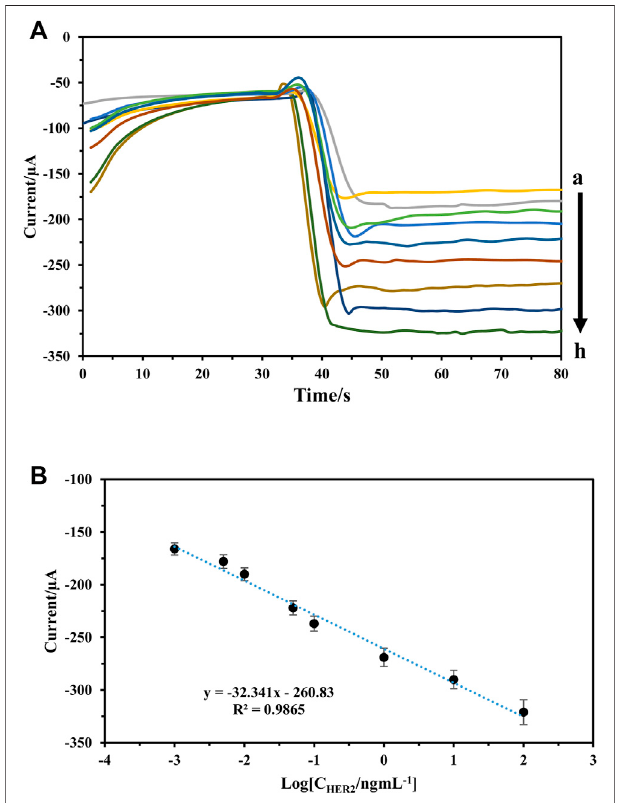
FIGURE 7 | (A,B) Amperometric response of the immunosensor to different concentrations of HER2, from a to )1 pg/ml, 5 pg/ml, 10 pg/ml, 50 pg/ml, 100 pg/ml, 1 ng/ml, 10 ng/ml, and 100 ng/ml (B) calibration curve of the immunosensor to different concentrations of HER2.